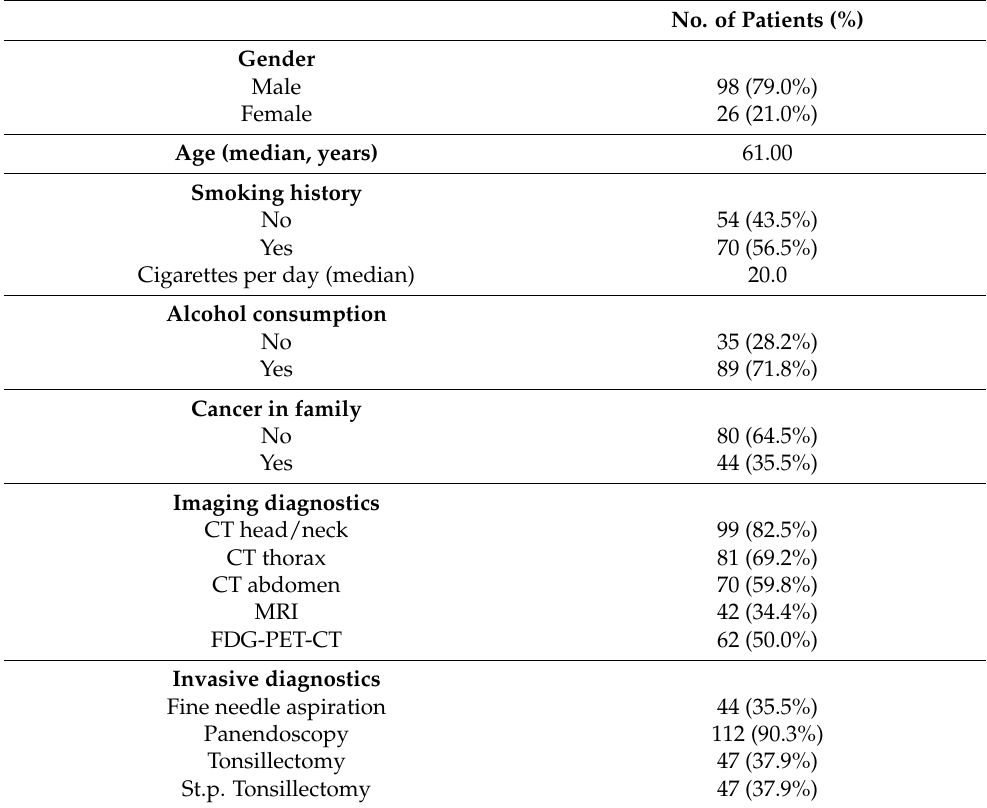
Table 1. Patient characteristics and details of diagnostic